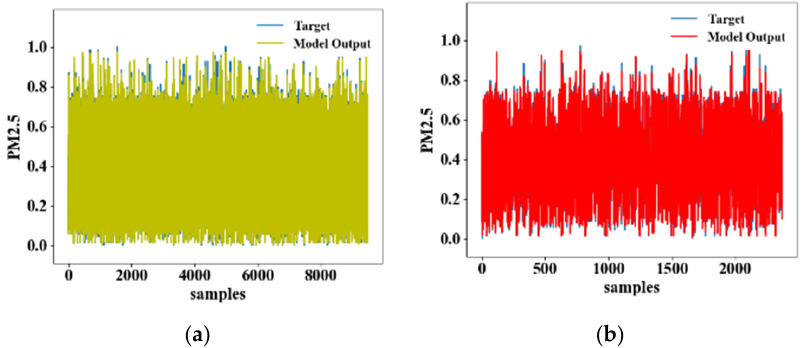
Figure 13. Learning results of the random forest model: ( a ) training set and ( b ) testing set.